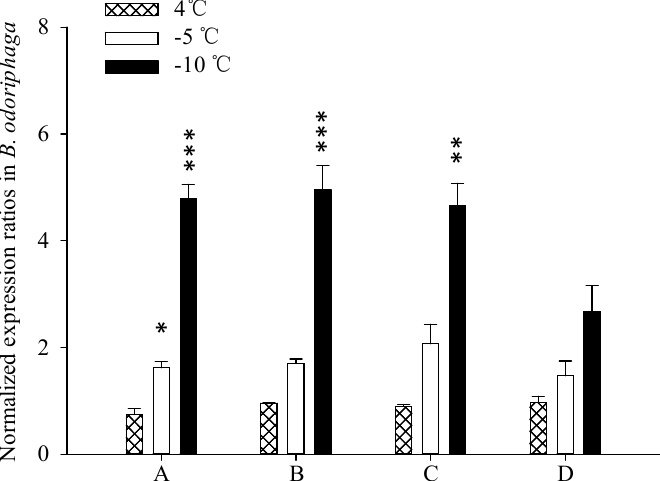
Figure 5. Relative expression of a target gene, HSP23 , was affected by three temperature treatments and standardized with different numbers, and kinds of reference genes. The expression level was separately normalized by: A ( RPS15 ); B ( RPS15 and RPL28 ); C (RPS15, RPL28 and GAPDH ); or D ( ACTb ) reference genes. The reference genes were selected depending on the expression stability of the 12 housekeeping genes among the three temperature treatments. Values are means ± SD of three biology replications; the “*” means remarkable differences, * p < 0.05; ** p < 0.01; *** p < 0.001.